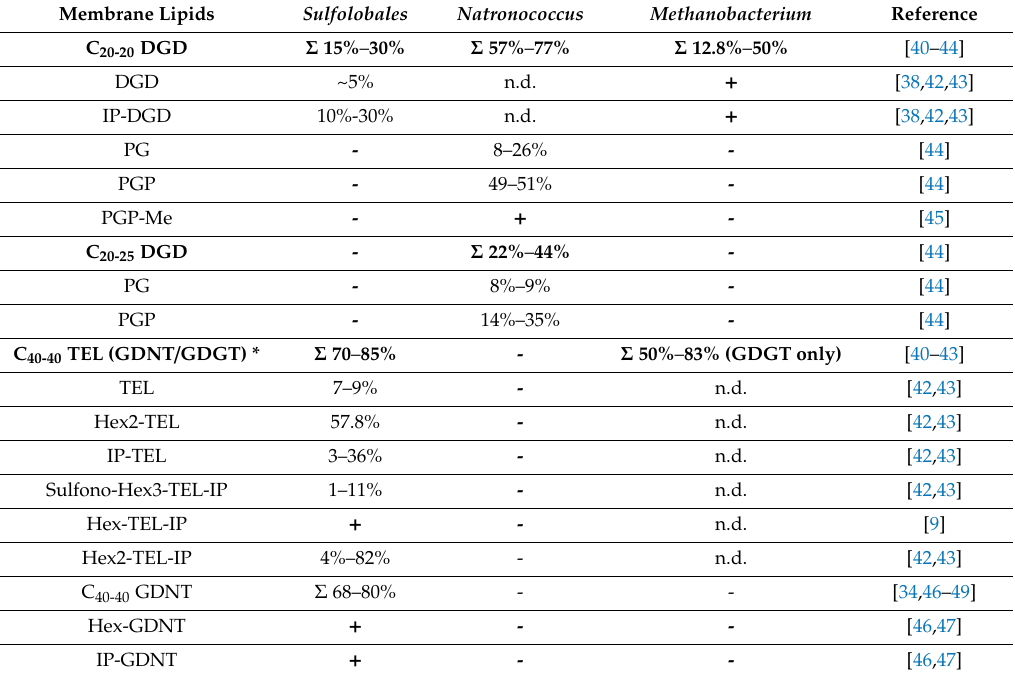
Table 1. Overview membrane lipid composition of Sulfolobales , Natronococcus and Methanobacterium . Membrane Lipids